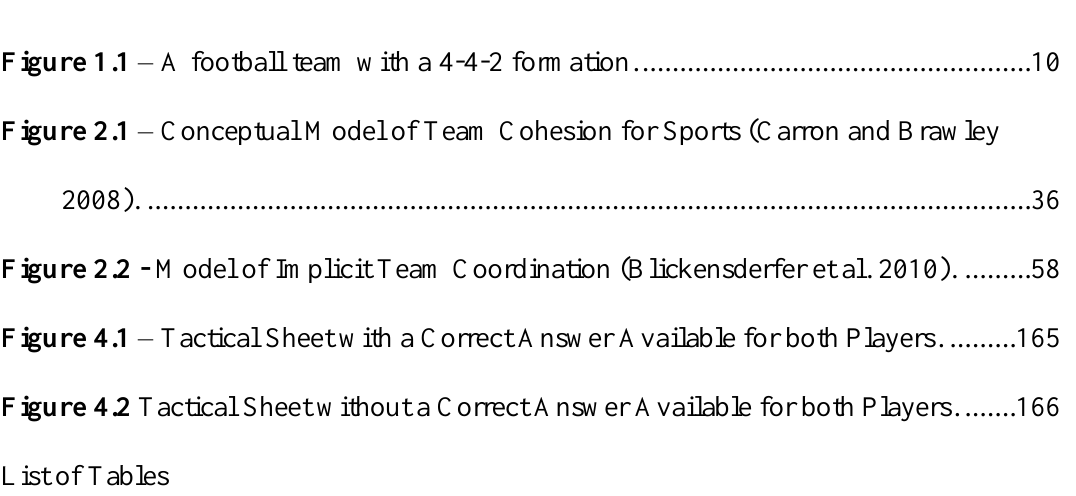
Figure 1.1 – A football team with a 4-4-2 formation. .................................................... 10 Figure 2.1 – Conceptual Model of Team Cohesion for Sports (Carron and Brawley